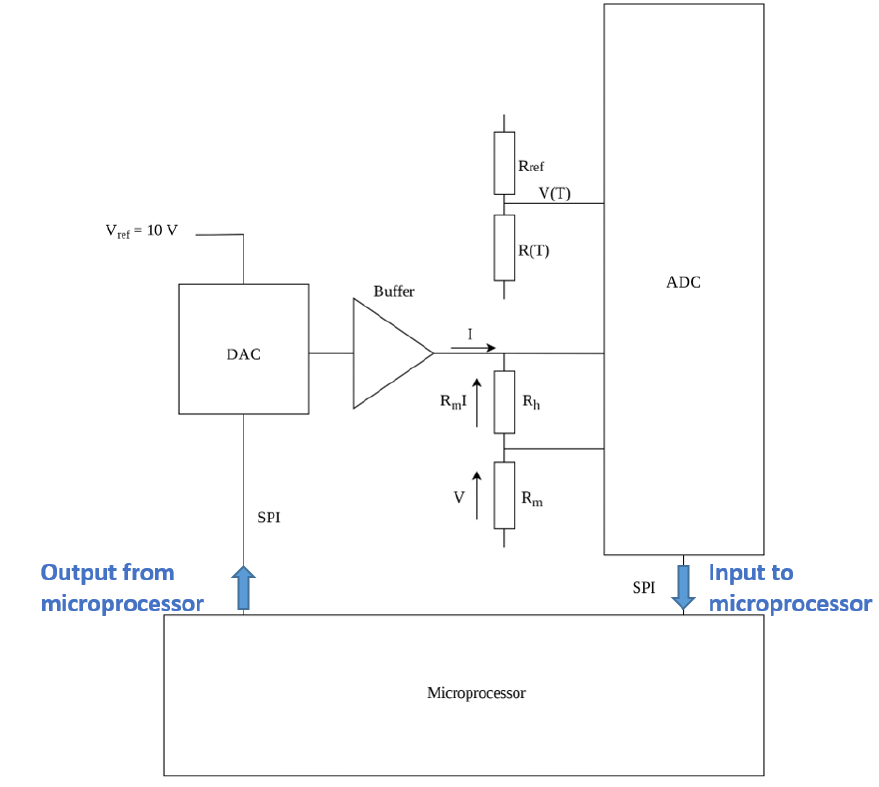
Figure 3. Scheme of the electronics of the radiometer servo